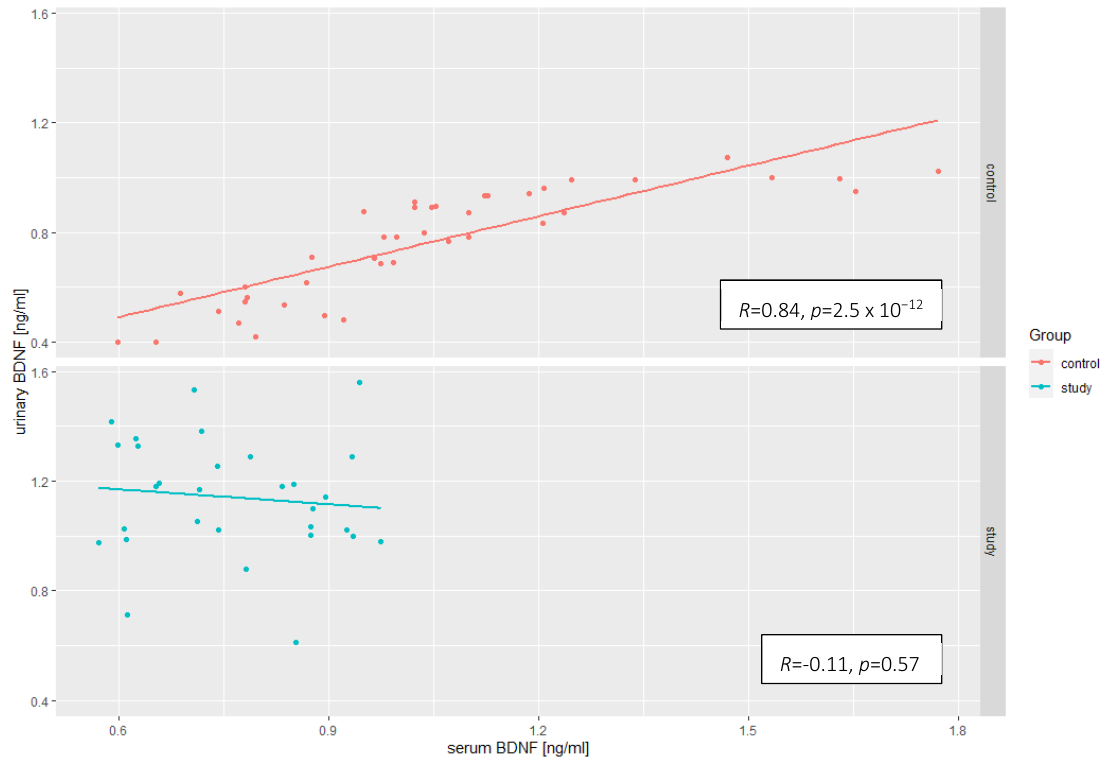
Figure 2. Correlations between the concentration of BDNF in the serum and urine, taking into account the division into the study group and the control group (R-Pearson’s correlation coefficient). We assessed the possible usefulness of BDNF as an INS marker using the ROC curve. The suggested cut-off point for serum BDNF was established at 0.9 pg/mL, with the AUC at 86.5%. Additionally, the urine BDNF cut-off point reached 1.0 pg/mL with AUC at 92.0% (Figure 3).